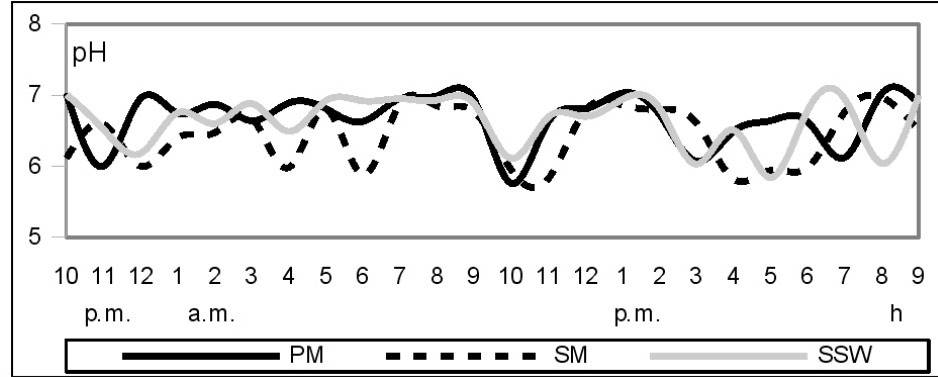
Figure 8. Diurnal variation in the pH in surface microlayers and subsurface water of Lake Dołgie